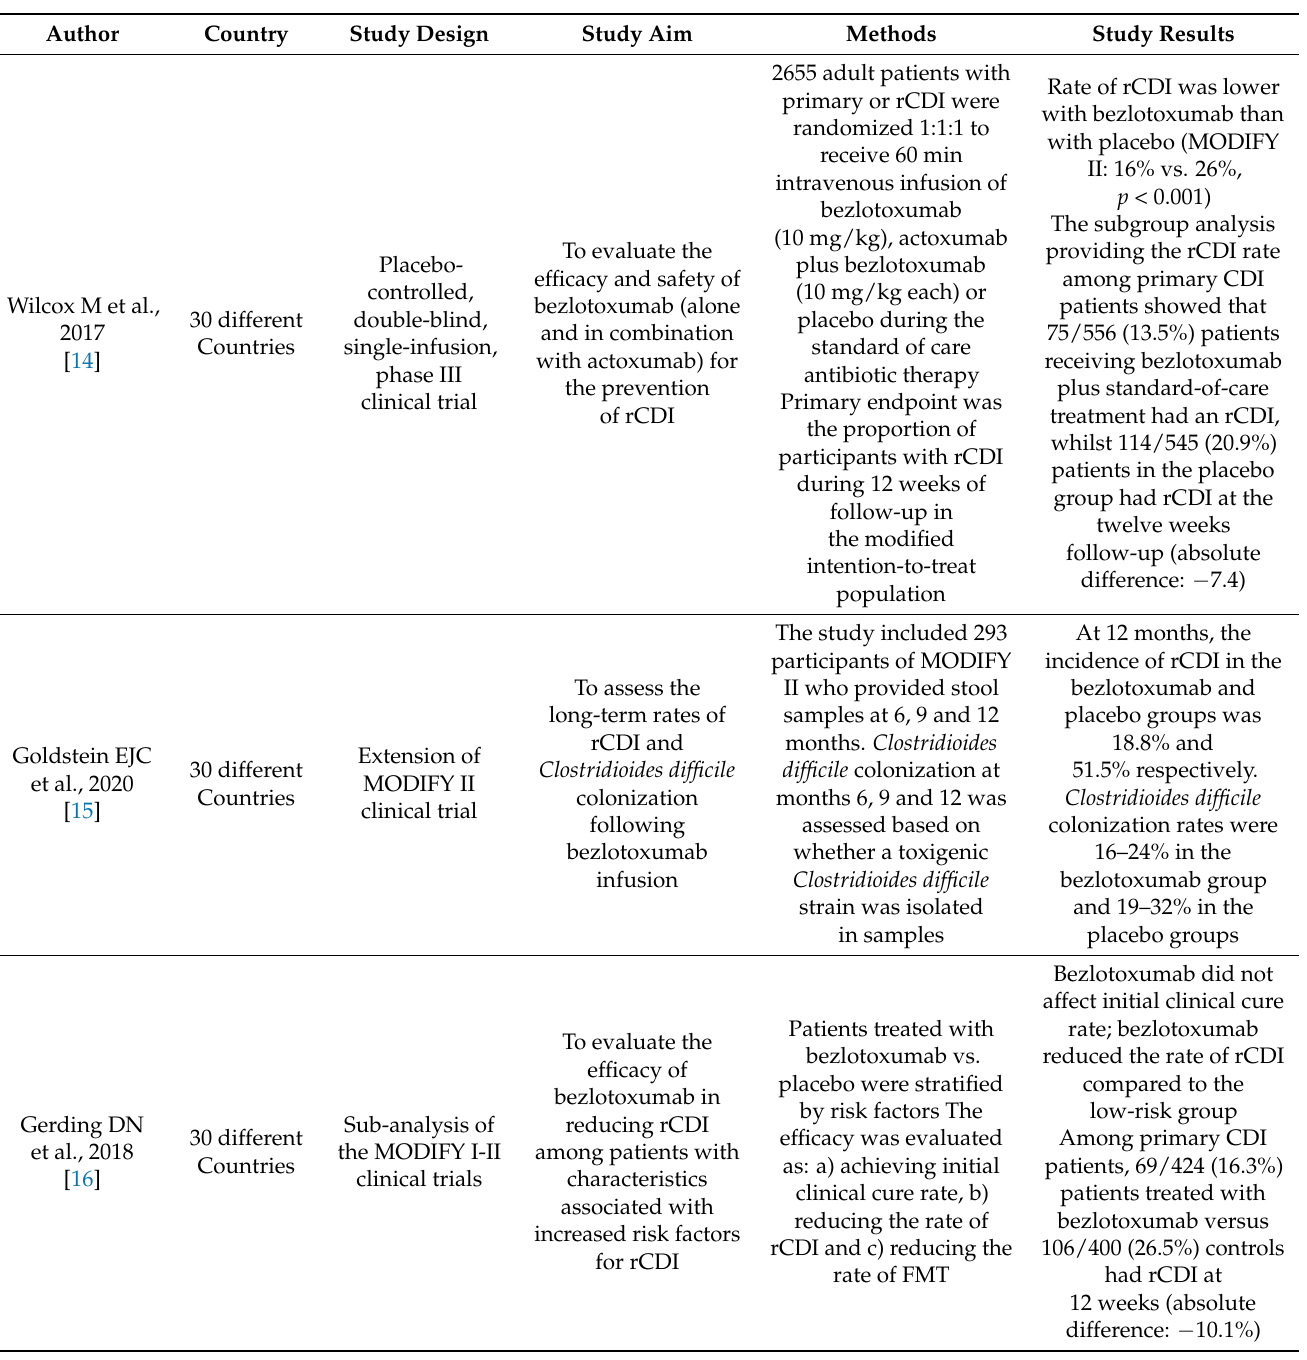
Table 1. Summary description of the 5 studies providing data on the use of bezlotoxumab for the prevention of rCDI after a first CDI